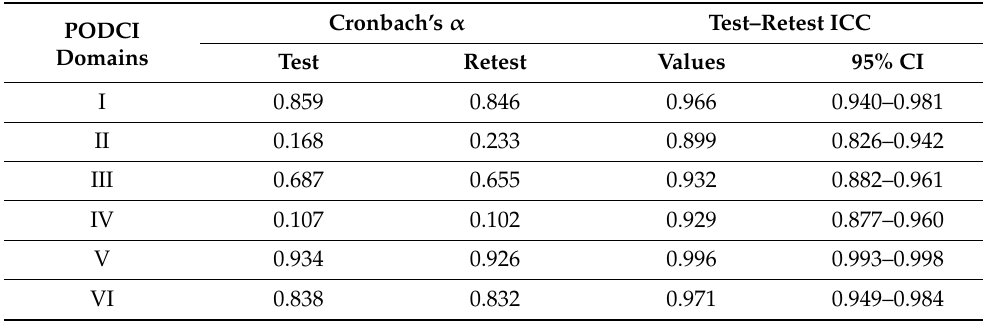
Table 3. Internal consistency (Cronbach’s α ) for test and retest sessions and test–retest reliability (Intraclass Correlation Coefficient, or ICC) for each PODCI domain.